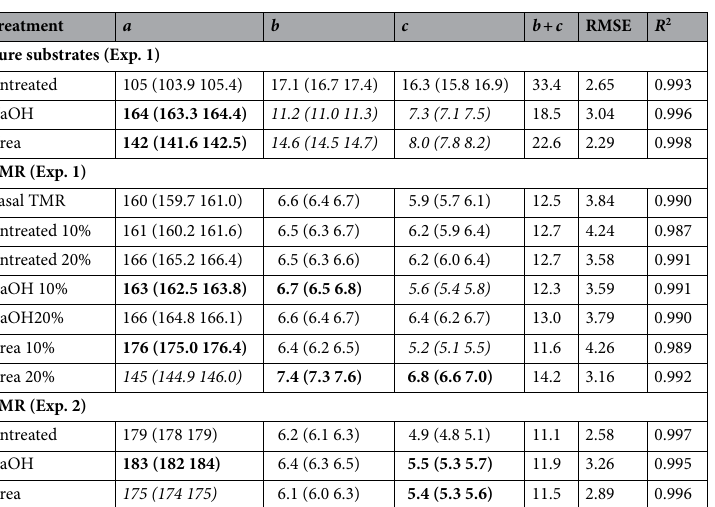
Table 4. Estimated model parameters for gas production kinetics of barley straw treatments, a model TMR composed of 45% barley grains, 2% soybean meal, and 53% lucerne chaff, the model TMR including the straw treatments with 10 or 20% of the proportion of lucerne chaff (Experiment 1), and practical TMR composed of 33.5% maize silage, 21.6% rapeseed meal, 26.7% barley grains, and 18.2% of one of the straw treatments on DM basis (Experiment 2). Gas production curves were modelled using Gompertz non-linear regression function according to Dhanoa et al . 31 . Likelihood ratio 95% confidence intervals are given in brackets. Values that are significantly higher than the untreated counterpart are highlighted in bold, values that are significantly lower are highlighted in italics. Barley straw treatments were untreated straw, NaOH treated straw, and urea treated straw and are specified in the text. The conducted experiments are specified in the text. a = asymptotic maximal gas production (mL/g DM), b = time (h) until which one-third of a is produced, c = time (h) between b and the time (h) b + c , until which approximately 70% of a is produced, RMSE, root mean square error; TMR, total mixed ration.